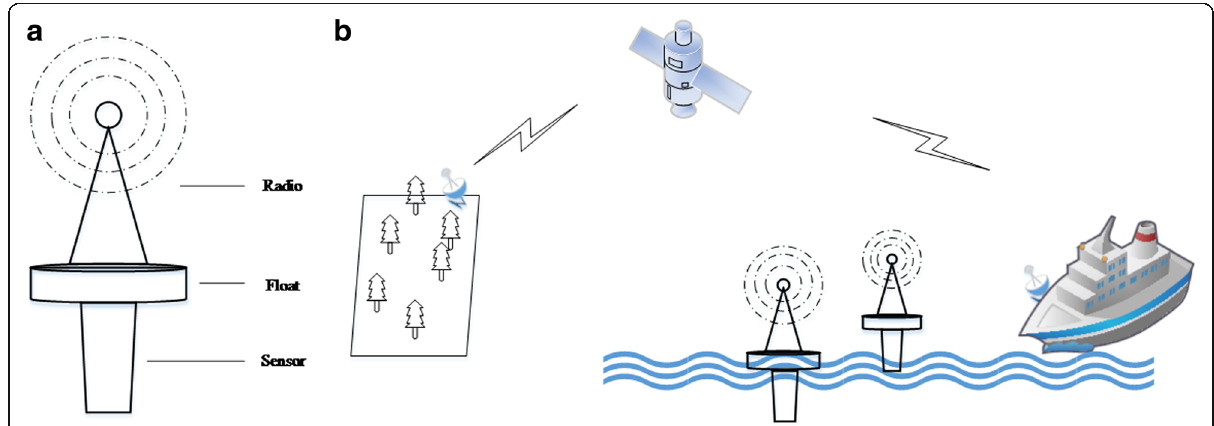
Fig. 4 a The structural representation of nodes in this aquaculture network. b The structural representation of monitoring and localization system in this aquaculture